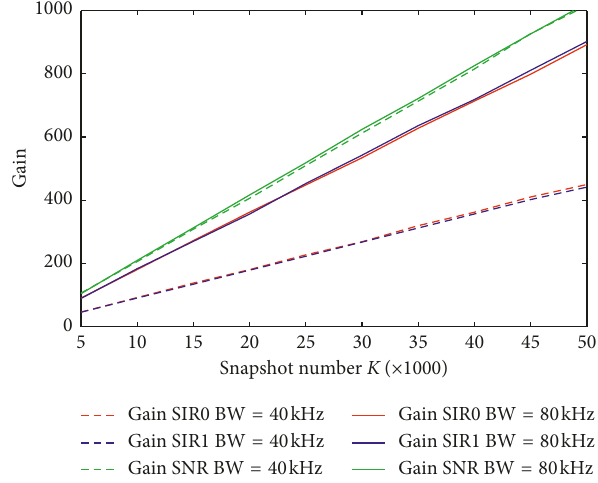
Figure 1: The SIR and SNR gains with different bandwidths and